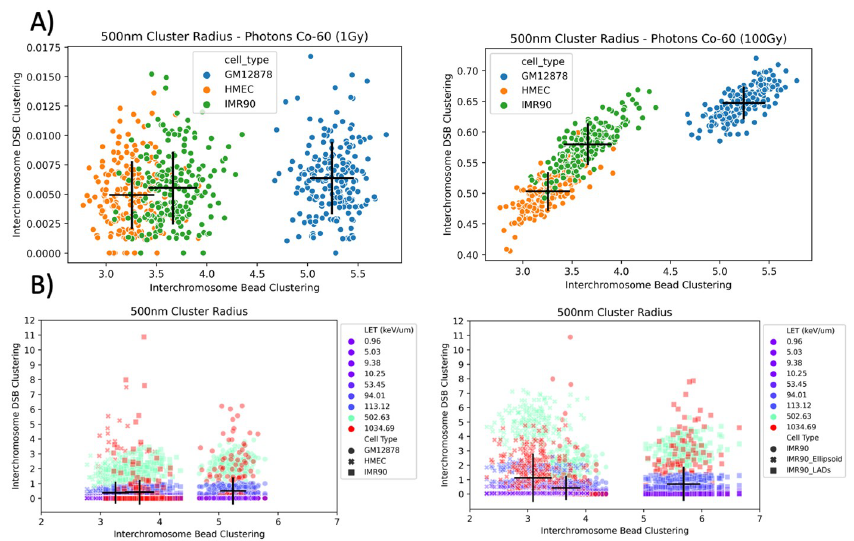
Fig 6. Evaluation of interchromosomal geometric bead clustering and subsequent damage clustering. A) relationship between interchromosomal bead clustering and interchromosomal DSB clustering for Co-60 photons irradiation at 1 Gy (left) and 100 Gy (right) at a 500 nm cluster radius. Black lines represent the standard deviation of each metric with the intersection corresponding to the mean value, each point represents a single G-NOME solved nucleus. B) same relationship of bead and DSB interchromosomal clustering, but for proton, helium- and carbon-ions of varying LET at cluster radii of 500nm with different cell-types (left) and cell variants